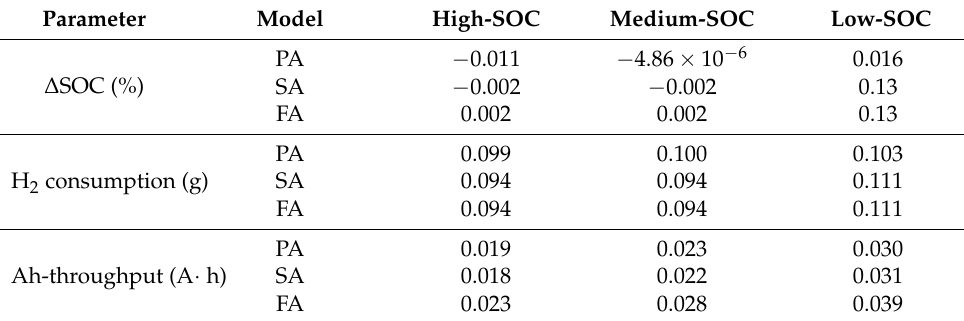
Table 13. Comparison of performance parameters hybrid configurations.